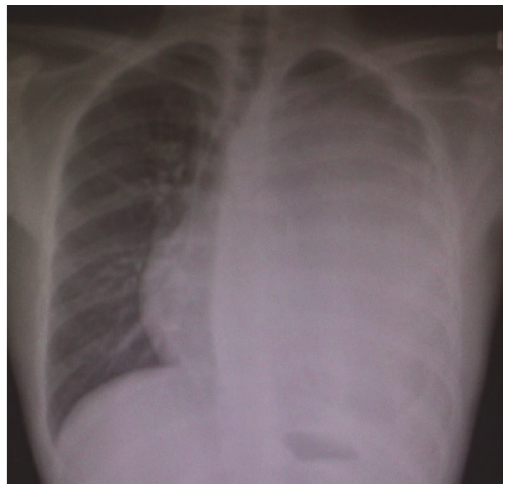
Figure 1: Chest radiograph showing left mediastinum mass.